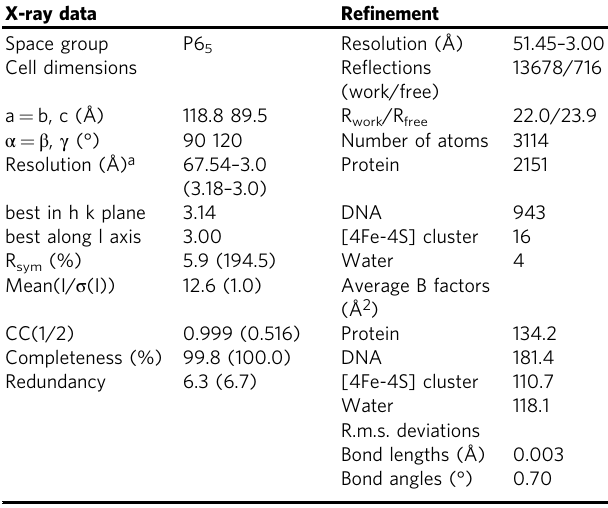
Table 1 X-ray data collection and re fi nement